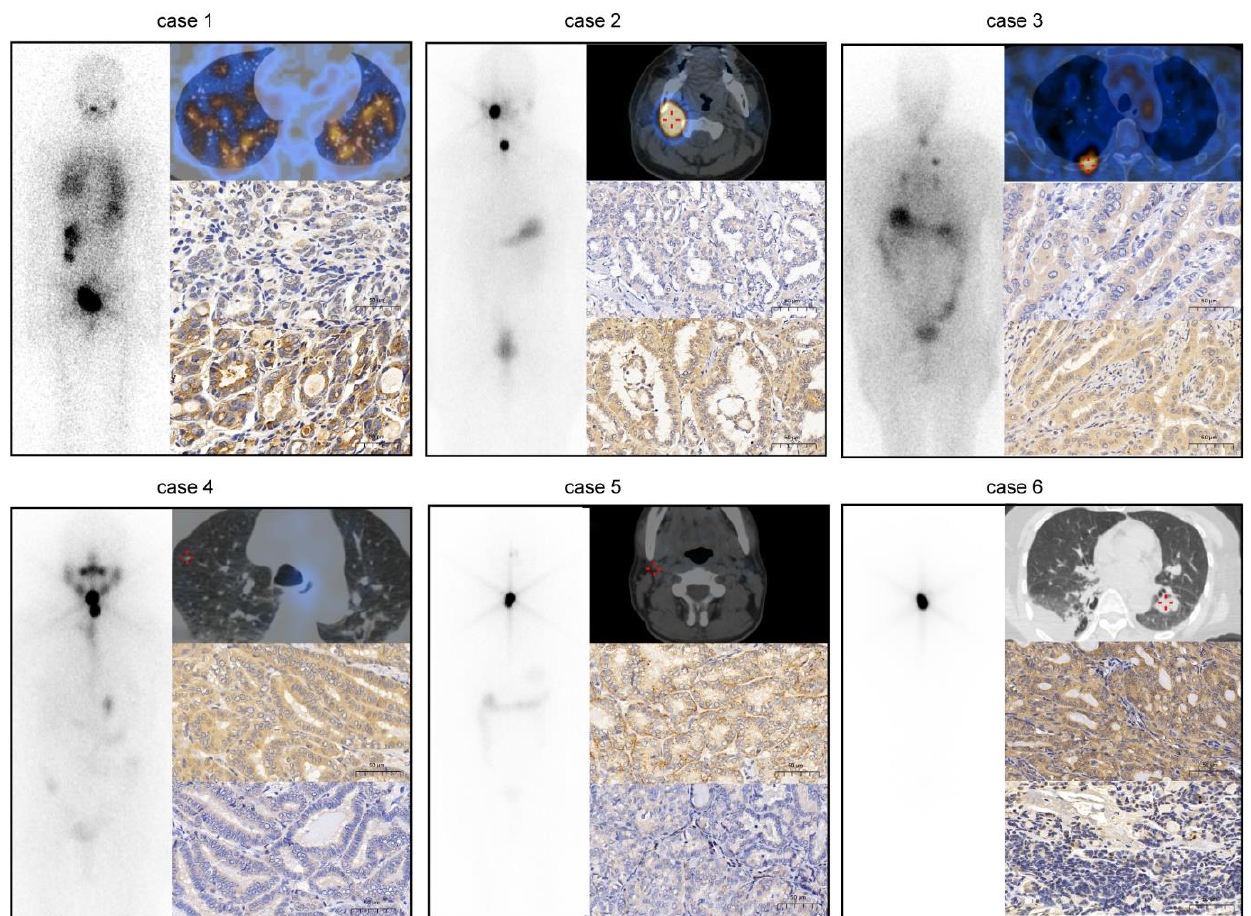
Figure 2. Post-therapeutic whole-body scan (Rx-WBS) with SPECT/CT after the initial course of 131 I and immunohistochemistry of IGF2BP2 and NIS of primary tumor in Representative cases. Patients (case 1: follicular variant, case 2: classic variant, case 3: tall cell variant) with low expression of IGF2BP2 in primary tumors were likely to show 131 I-avid lesions on Rx-WBS. Patients (case 4: tall cell variant, case 5: follicular variant, case 6: follicular variant) with high expression of IGF2BP2 in primary tumors were likely to show 131 I-nonavid lesions on Rx-WBS. Scale bar: 50 µm.